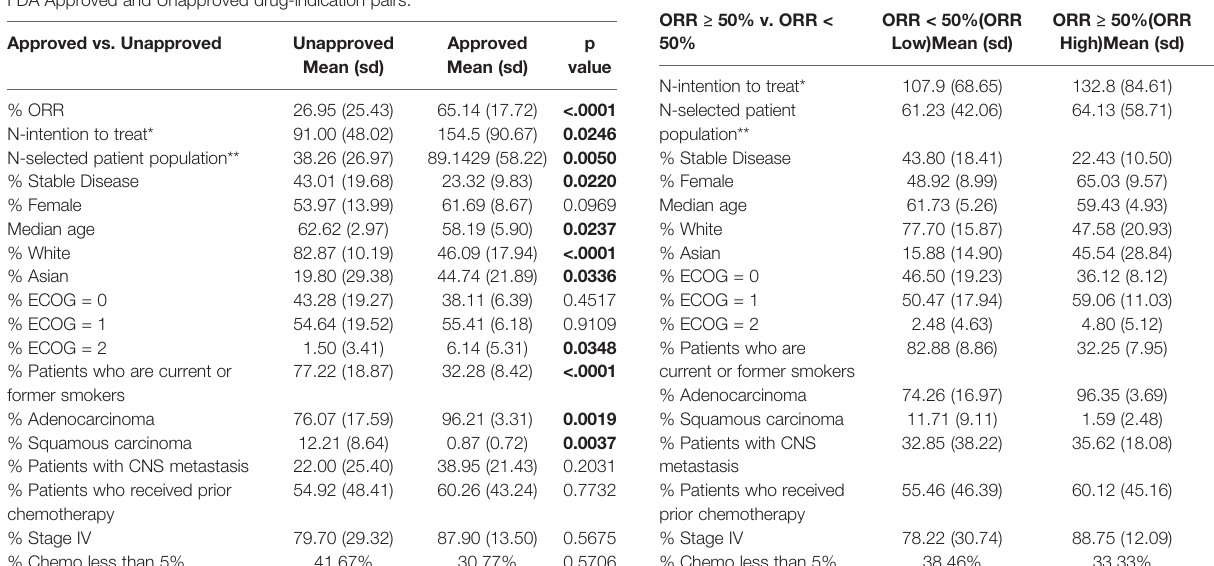
TABLE 2 | Patient characteristics differ signi fi cantly between Phase II studies of objective response rate (ORR) High (ORR ≥ 50%) and ORR Low (ORR <50%) drug-indication pairs. TABLE 1 | Patient characteristics differ signi fi cantly between Phase II studies of